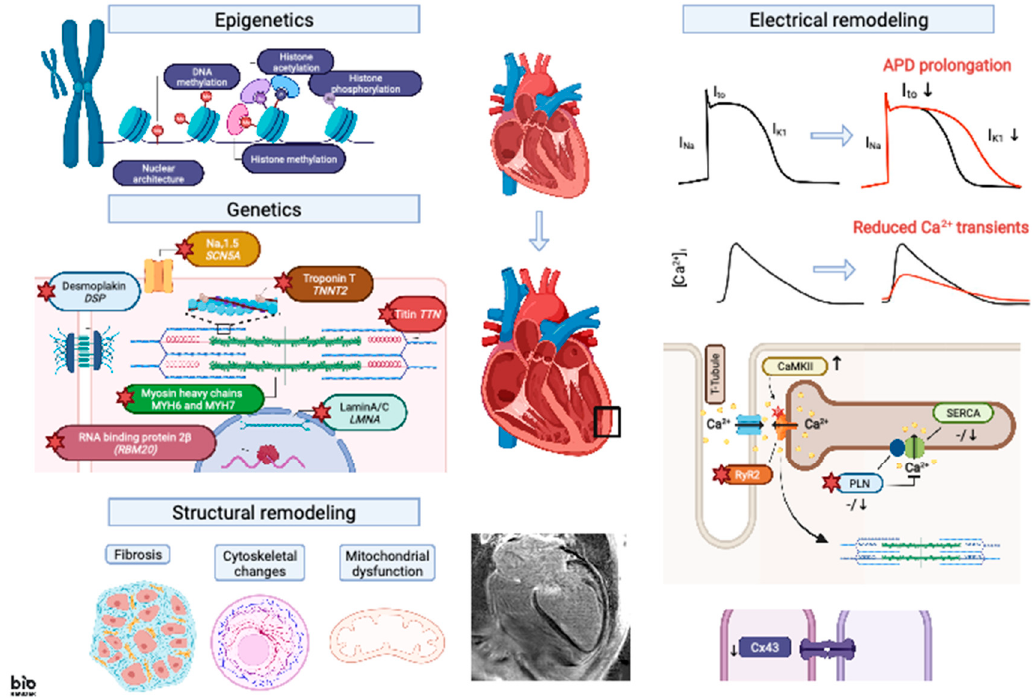
Figure 1. Graphical abstract on electrical ventricular remodeling in dilated cardiomyopathy.